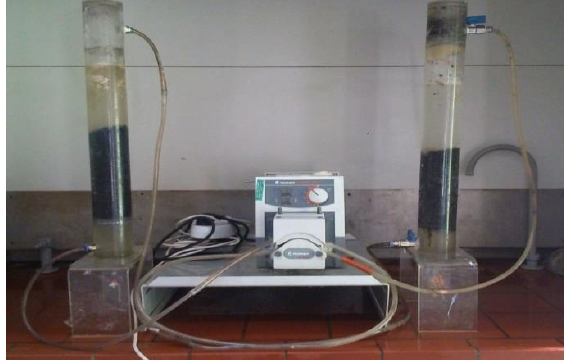
Figure 2. The granular activated carbon submerged up-flow reactors, (a) nitrification column and (b) denitrification column Each Plexiglas column was 42 cm in height and had an inner diameter of 10 cm and a screen layer of 2 mm diameter was installed at the bottom of each column. The reactors were made watertight at the bottom and top using O-ring flanges to prevent the transfer of atmospheric gases to the anaerobic zone. GAC (500 g) with a size of 2–4 mm was packed into both columns with a height of